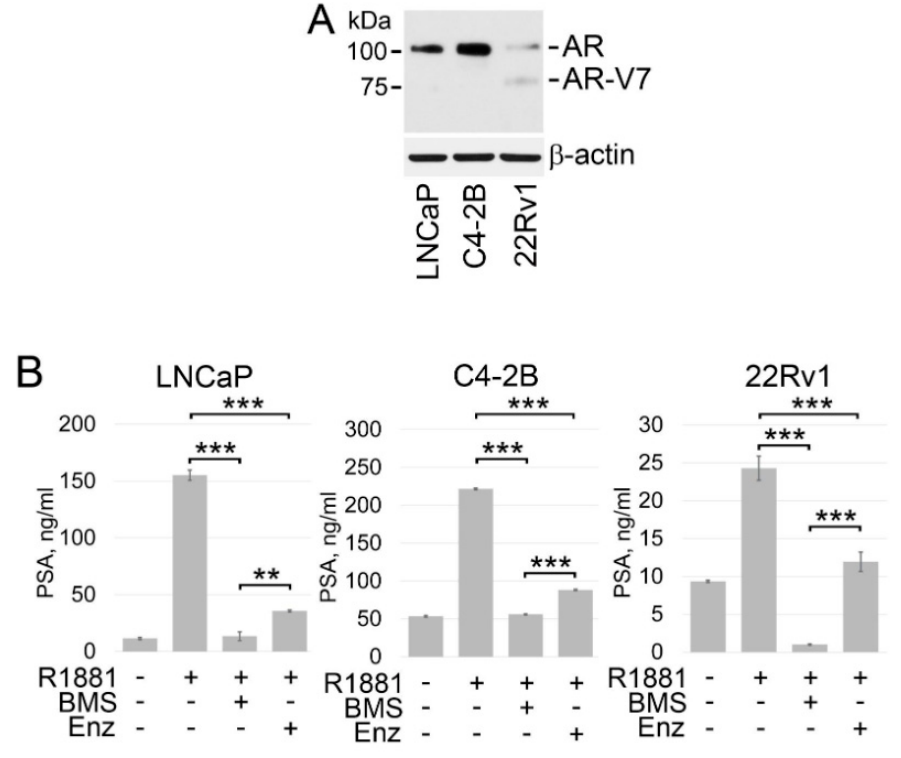
Figure 5. ACLY inhibition results in the suppression of ligand-dependent and -independent PSA expression. ( A ) Western blot analysis of the AR expression in LNCaP, C4-2B, and 22Rv1 PC cells. ( B ) LNCaP, C4-2B, and 22Rv1 cells were cultured under androgen-depleted conditions for 24 h fol- lowed by treated with BMS 303141 (BMS) (30 μ M), enzalutamide (Enz) (2.5 μ M), and R1881 (1 nM) in for 18 hrs. Expression of PSA was examined in the cell culture supernatants using PSA ELISA kit. Columns, means of three different experiments; bars, SDs. ** p < 0.001; *** p < 0.0001. Full size blots of are shown in Figure S4.